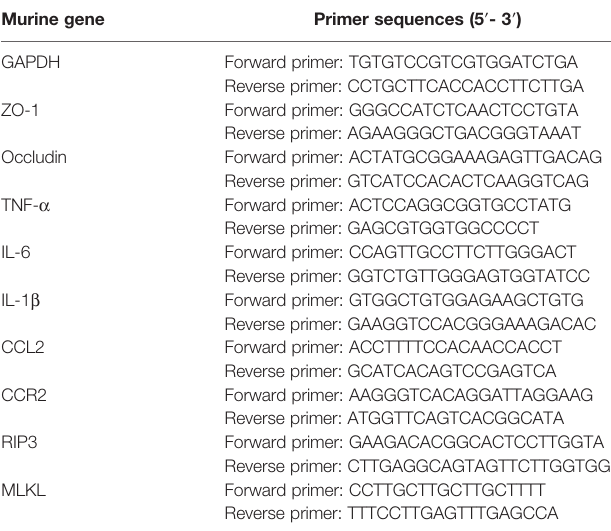
TABLE 2 | The Oligonucleotide primers used in Realtime-PCR analysis. Murine gene Primer sequences (5 ′ - 3 ′ )